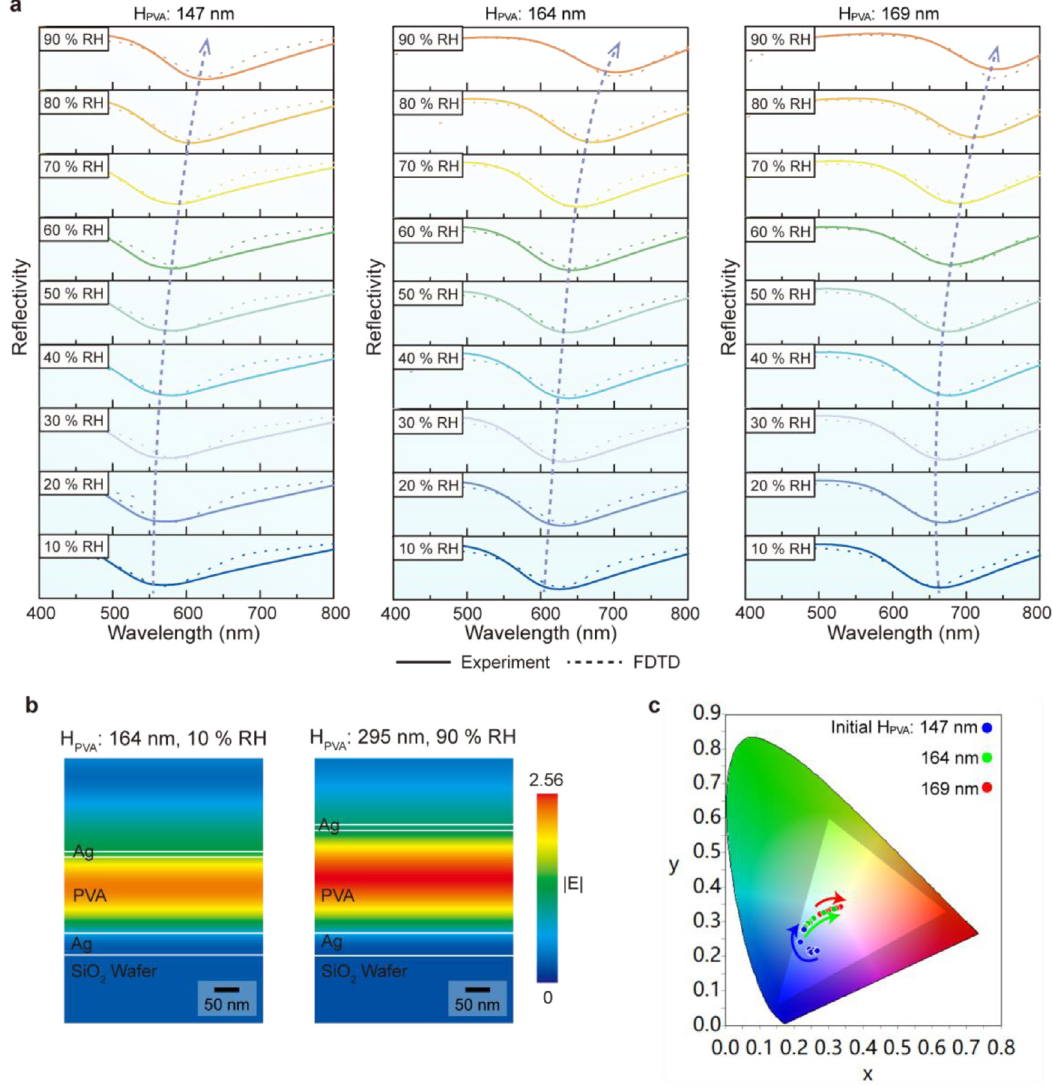
Fig. 4. (a) Experimental and simulated re fl ection spectra at stepwise increasing ambient humidity from 10 to 90% RH. (b) The simulated electric- fi eld distribution for MHM nanocavity with the initial H PVA of 164nm at 10% RH and fully-swelled H PVA of 295 nm at 90% RH. (c) CIE 1931 diagram of the real-time color change of MHM nanocavities between 10% and 90% RH. H PVA values for (a) and (c) are selected as 147, 164 and 169 nm,